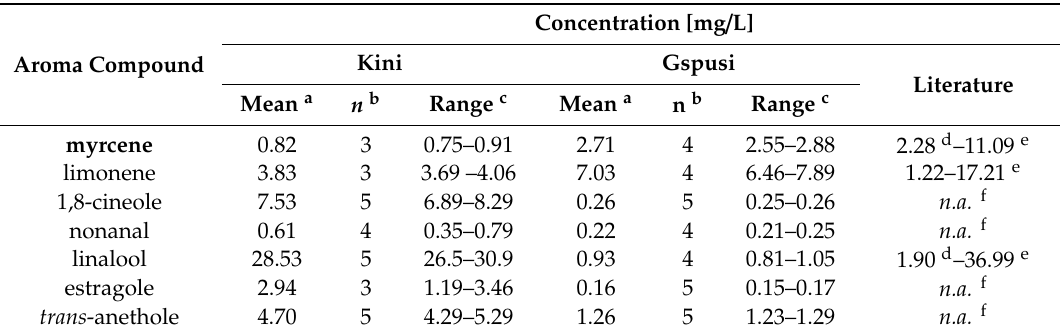
Table 2. Concentrations of selected aroma-active compounds in The King Gin Kini and Gspusi gins, as determined via stir-bar sorptive extraction (SBSE) and stable isotope dilution analysis (SIDA), in comparison to values obtained from the